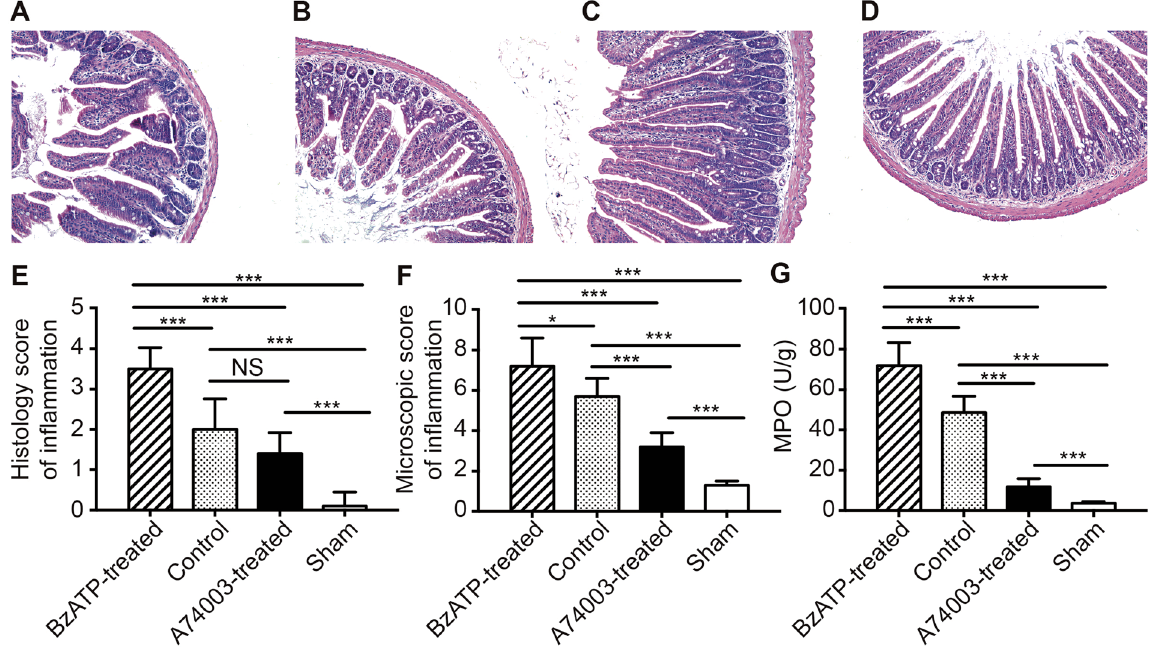
homogenized and protein was extracted for MPO activity analysis. N = 6 mice per group. The data are